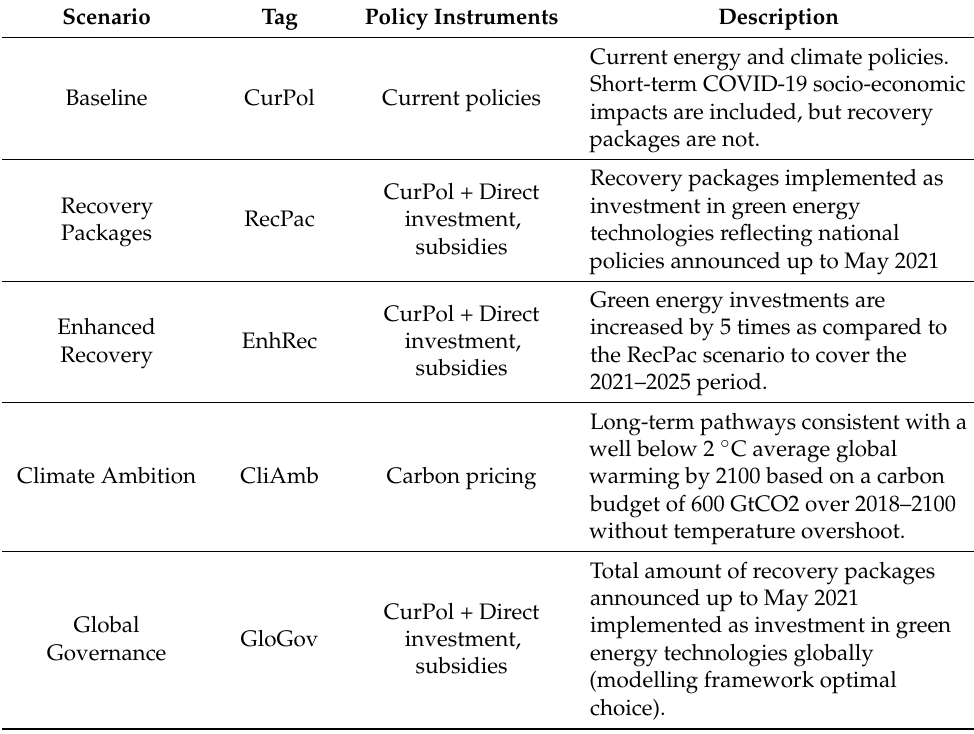
Table 1. Summary of policy